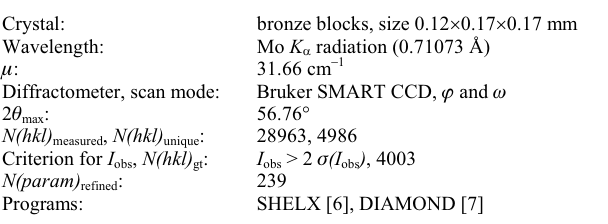
Table 1. Data collection and